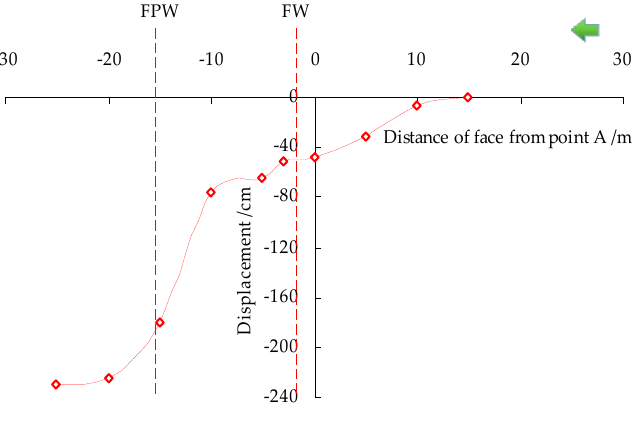
Figure 30. The displacement of point A.